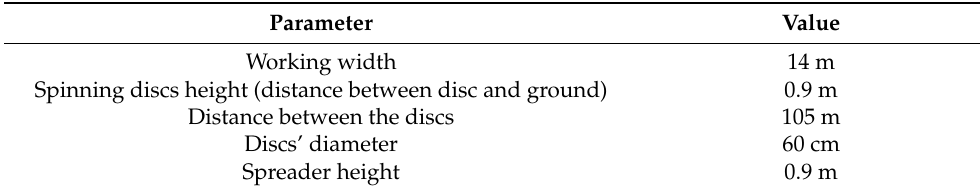
Table 2. Parameters of fertilizer spreader Amazone ZA-M used to create spreader and rotating discs